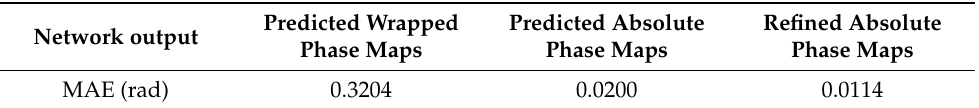
Table 1. MAE of predicted wrapped phase maps, predicted absolute phase maps, and refined absolute phase maps in the entire test set.